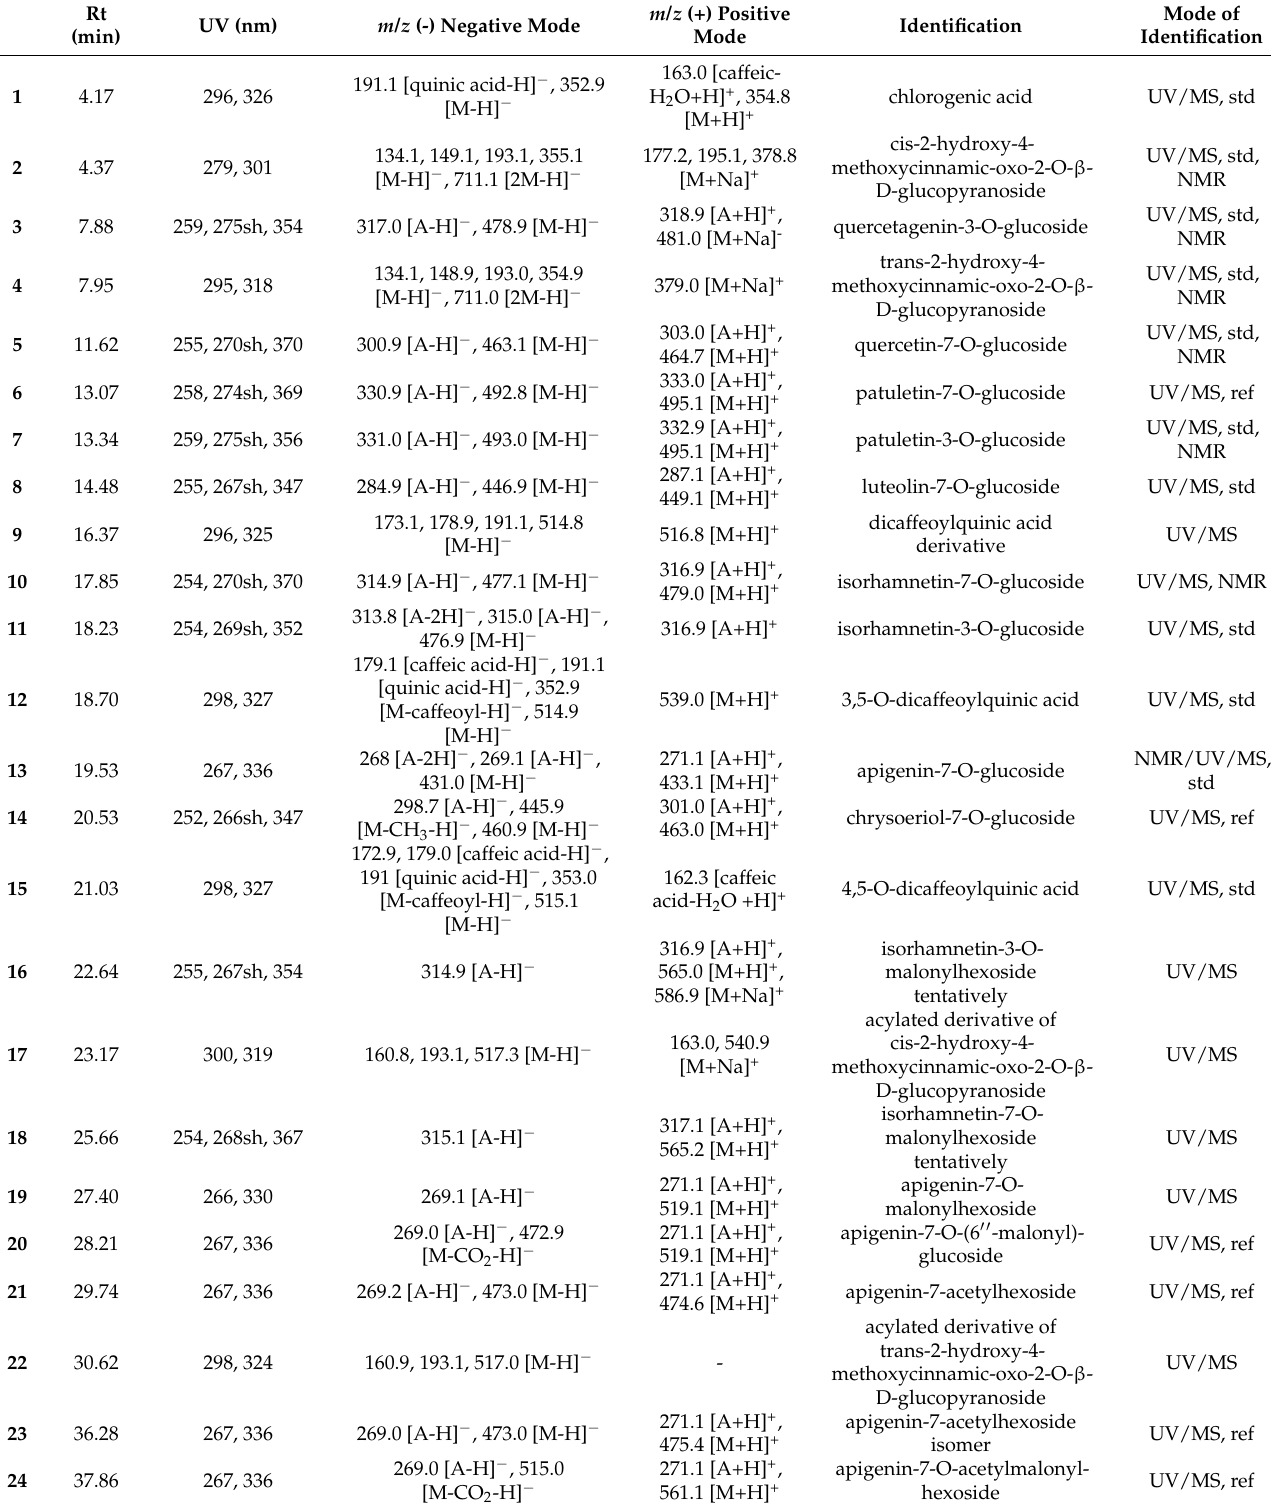
Table 1. MS fragmentation and UV-vis absorption data of the compounds detected in the methanol extract of Matricaria recutita flowers of the studied